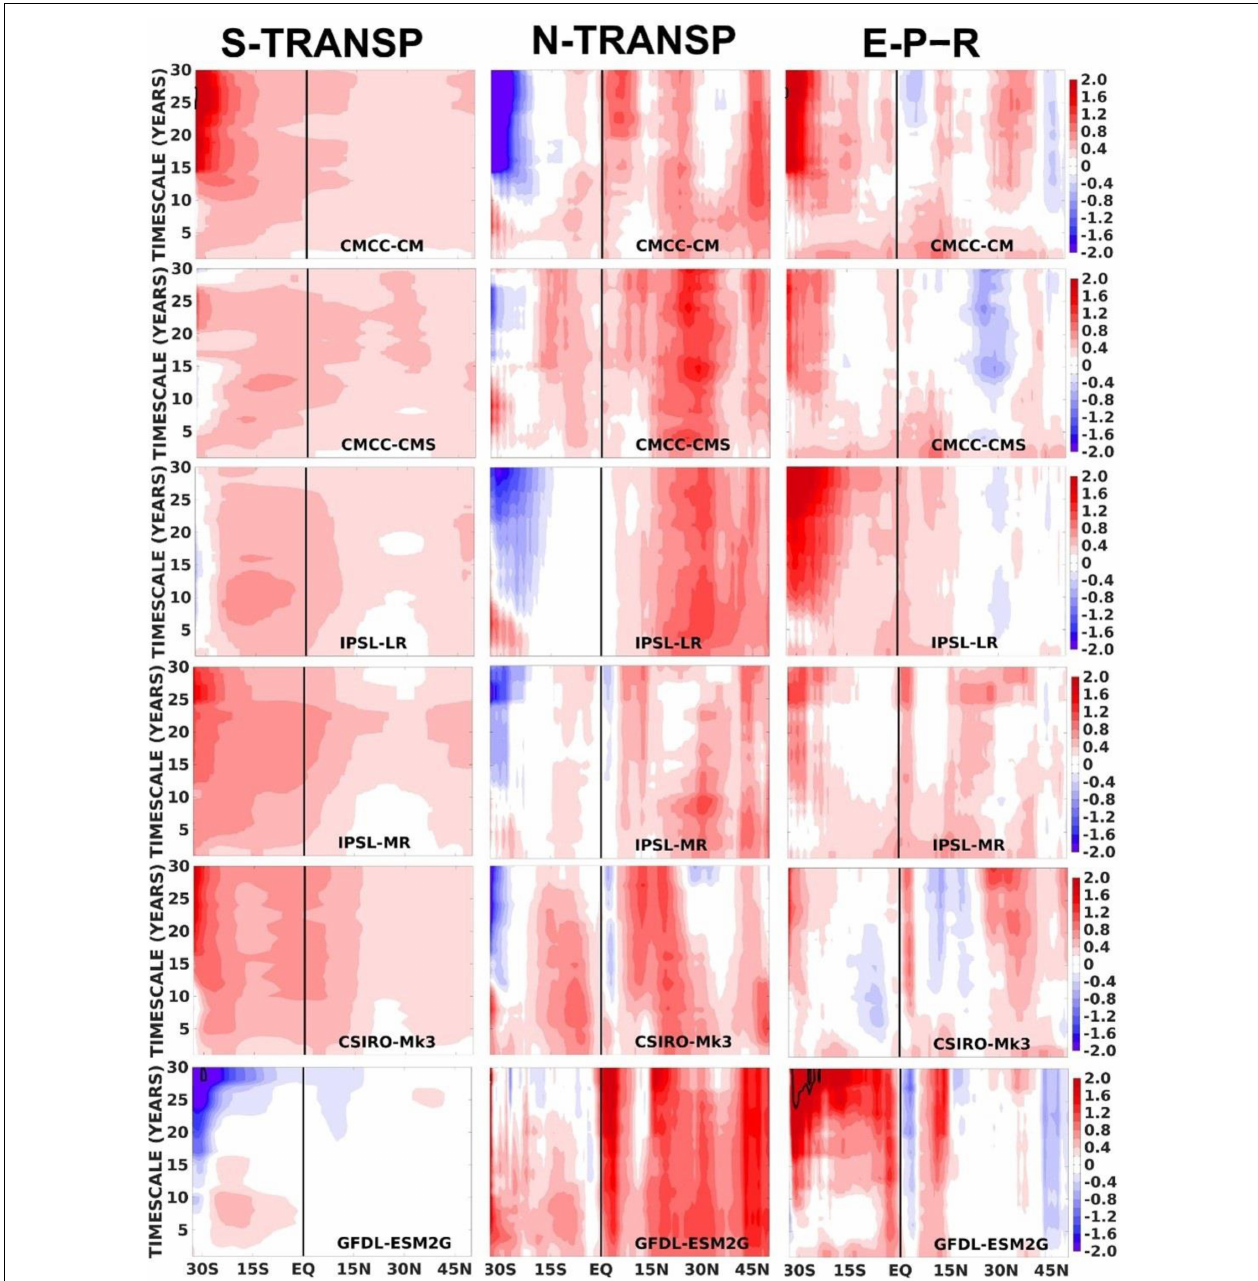
FIGURE 8 | Normalised covariances of the total southern transports, total northern transports and E-P-R with FWC changes as in Eq. 8, considering a fixed southern boundary at 34 ◦ S and a moving northern boundary from 33 ◦ S to 50 ◦ N. The spatially varying normalised covariances are evaluated from interannual to multidecadal timescales. The black contours correspond to either negative or positive normalised co-variance values > 3.